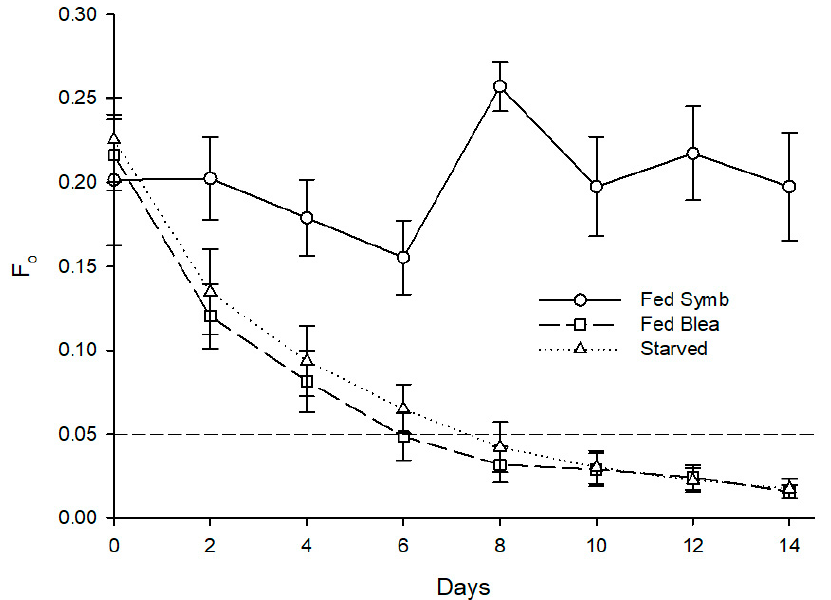
Figure 6. Evolution of fluorescence parameter F o in photosynthetic dinoflagellate endosymbionts hosted by Berghia stephanieae reared under different diets (mean ± std. error, starting n = 10). Fed Symb—fed with symbiotic anemones ( Exaiptasia diaphana ), Fed Blea—fed with bleached anemones. The dashed line indicates the threshold of F o corresponding to the absence of endosymbionts detectable in sea slugs’ cerata using microscopy.